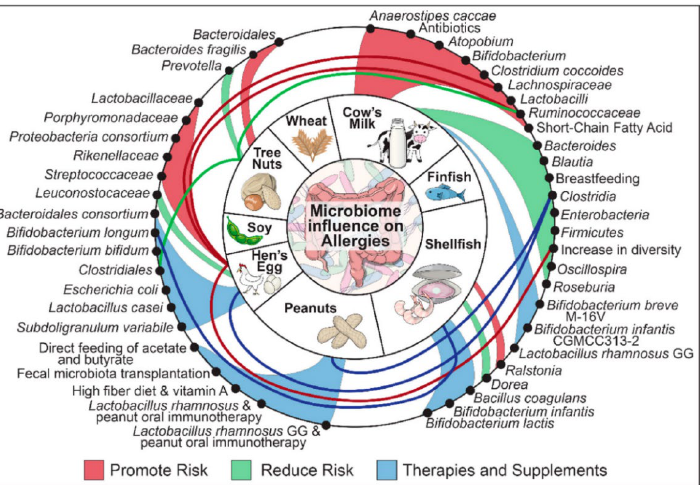
Figure 4. The relationship between the big eight food allergens and gut microbiota [113]. The advantage of Ralstonia would promote the allergic risk of shellfish, while Dorea would reduce the risk. Moreover, Bacillus coagulans , Bifidobacterium infantis , and Bifidobacterium lactis have the potential for shellfish allergic reactions therapies.